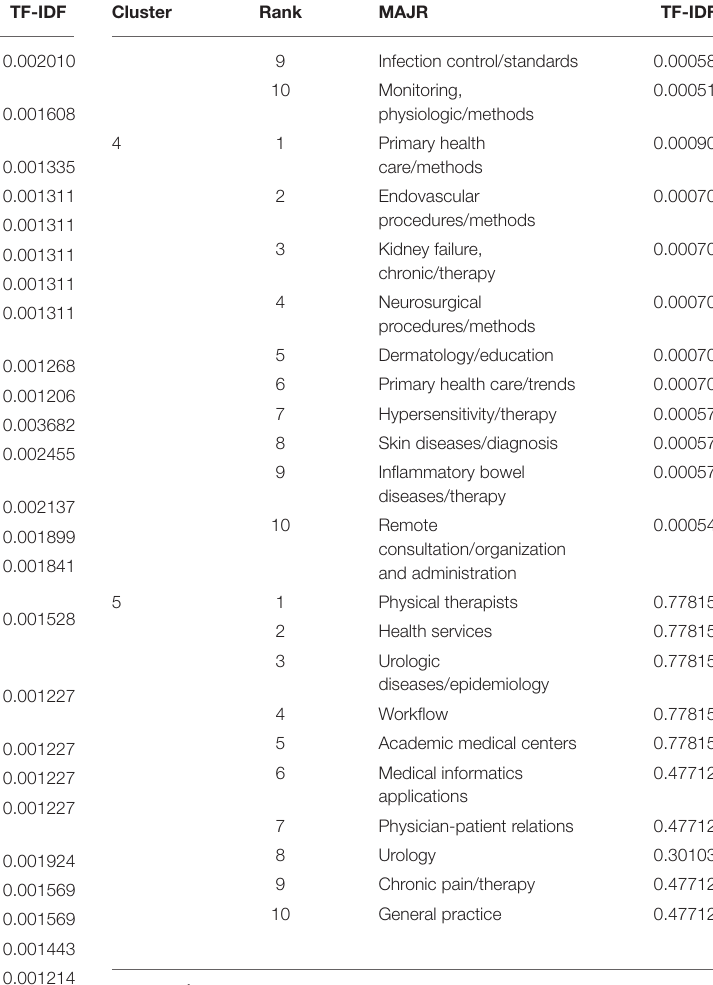
TABLE 3 | Top 10 TF-IDF values of MAJR in each cluster. Cluster Rank